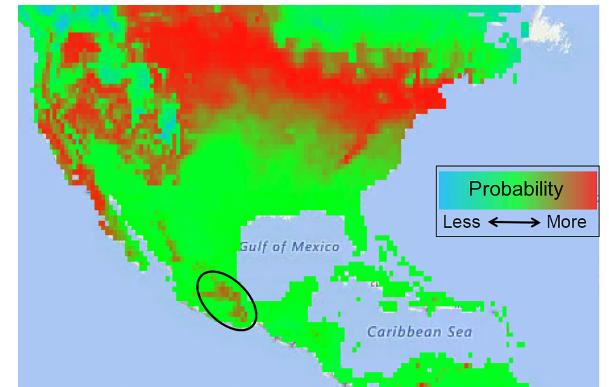
Figure 5. Example of an assignment map created with IsoMAP software. Warm colors (red to orange) indicate higher probability that the fruit water was sourced from that location, while cooler colors (blue, exclusive of ocean area) indicate lower probability. Fruit source water δ 18 O values used are from the tomatoes shown in Fig. 4 and Table 1. Black outline over central Mexico highlights the probable source location for the tomatoes. The most immedi- ate observation from Fig. 5 is that large regions are indicated with high probability of being the tomato source area, and that no sin- gle location or region provides a unique solution (see Sect. 4.2 for